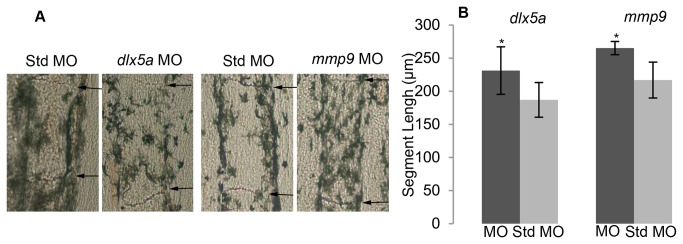

dlx5a and mmp9 are necessary for correct joint placement.(A) Segment length is increased following targeted gene knockdown of dlx5a and mmp9 compared with standard control (std) morpholino knockdown (negative control). (B) Segment length is increased in dlx5a-knockdown and mmp9-knockdown fins compared with standard control morpholino. Statistically different data sets (*) were determined by the student’s t-test where p<0.05. The p-value for the comparison of segment length for the dlx5a-treated fins was p = 0.0047. The p-value for the comparison of segment length for the mmp9-treated fins was p = 0.0018. Error bars represent the standard deviation. MO, morpholino.